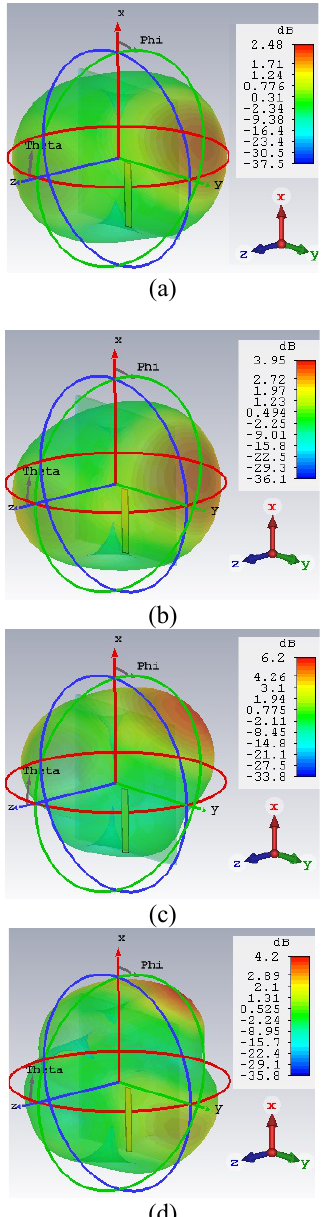
Figure 10: The far-field simulated 3-D radiation patterns of the proposed slot antenna at: (a) 1.65 GHz, (b) 3.14 GHz, (c) 4.44 GHz, and (d) 5.24 GHz.